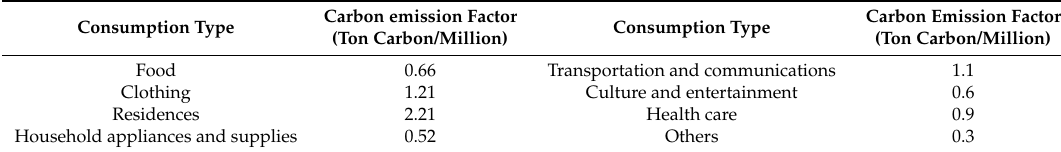
Table 4. Consumption of consumer goods carbon emission factor table [40] (unit: ton